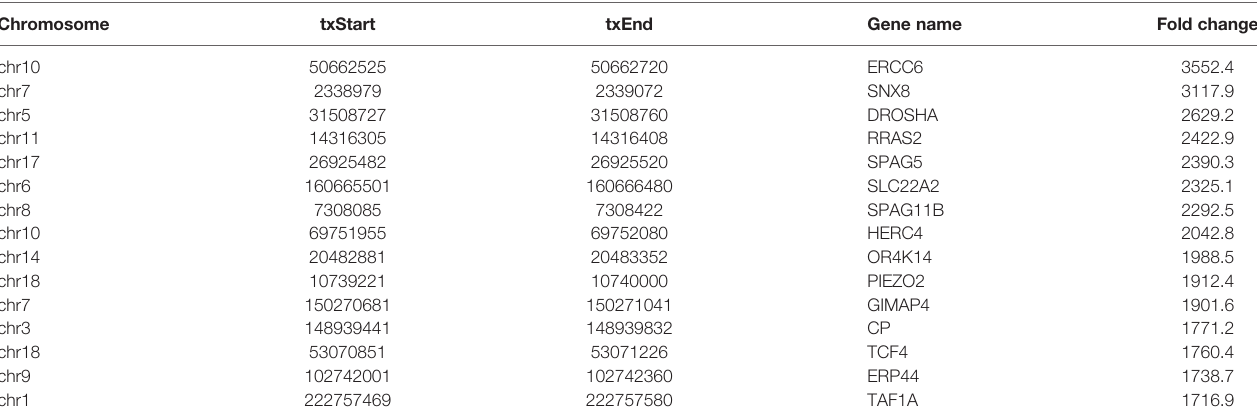
TABLE 2 | Top 15 down-methylated genes (HL60/MX2 vs HL60).